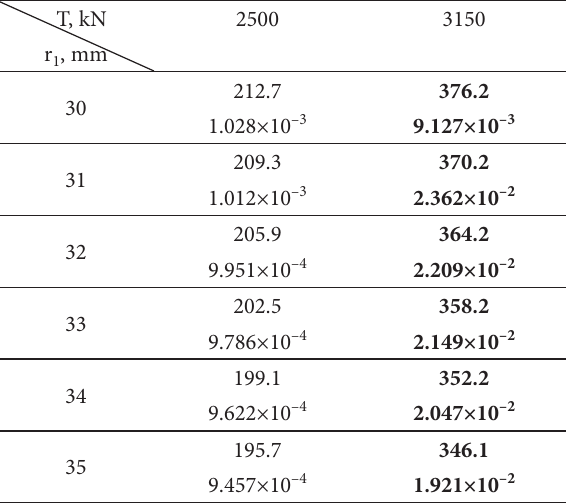
Table 3. Strains and stresses (MPa) in the body of the automatic coupler at the transition between the head and the body (2) for diff erent radius r 2 values T, kN